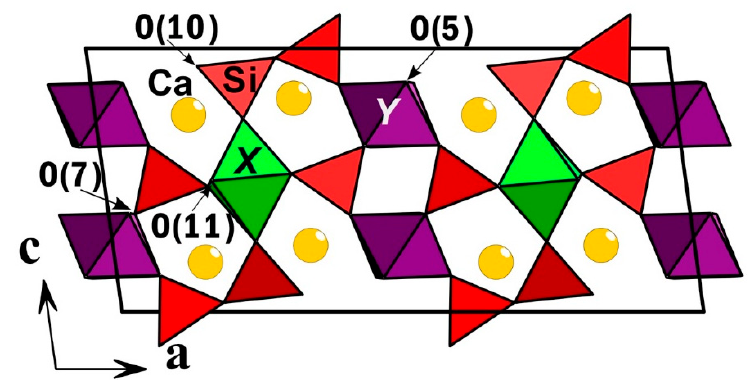
Figure 3. General view of the crystal structure of shuiskite-(Cr). Anion sites with full [O(5) and